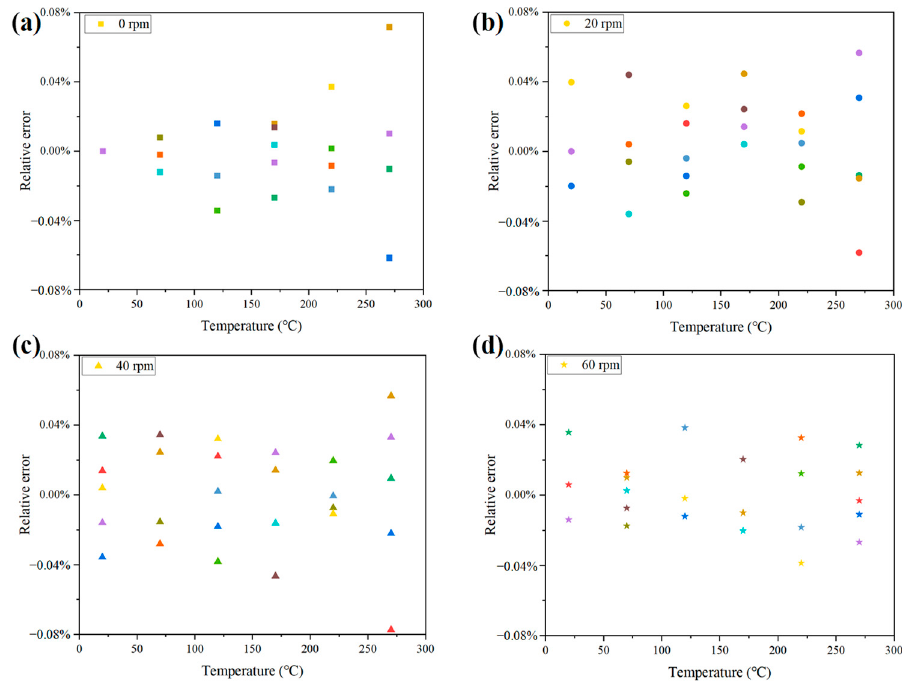
Figure 12. Relative error of the wireless LC conformal temperature sensor at different rotational speeds. ( a ) 0 rpm; ( b ) 20 rpm; ( c ) 40 rpm; ( d ) 60 rpm.